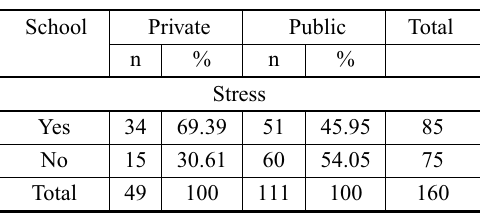
Absolute and relative frequency (%) of stress based on the private and public